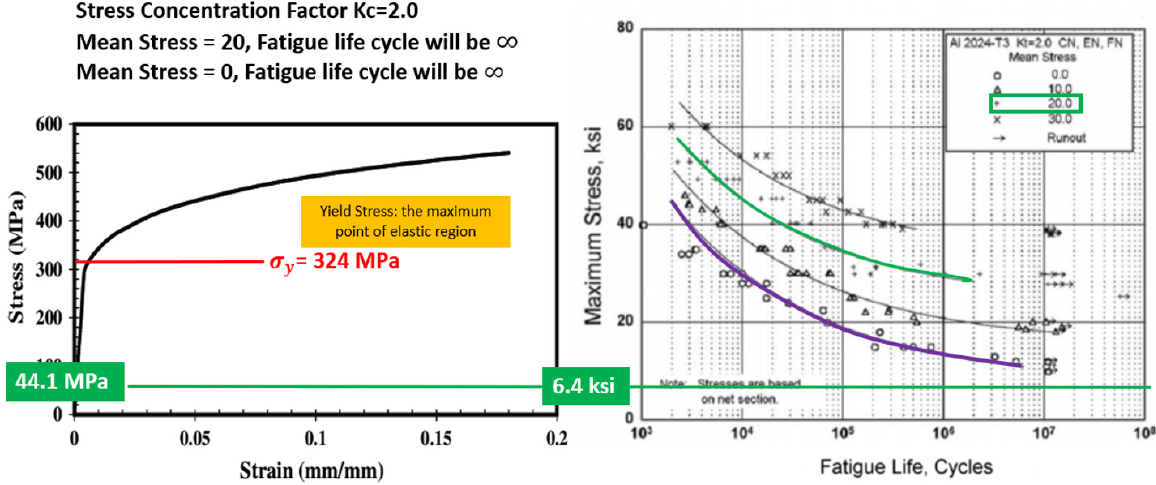
Figure 21. Equivalent Stress and Fatigue Life Cycle [26].